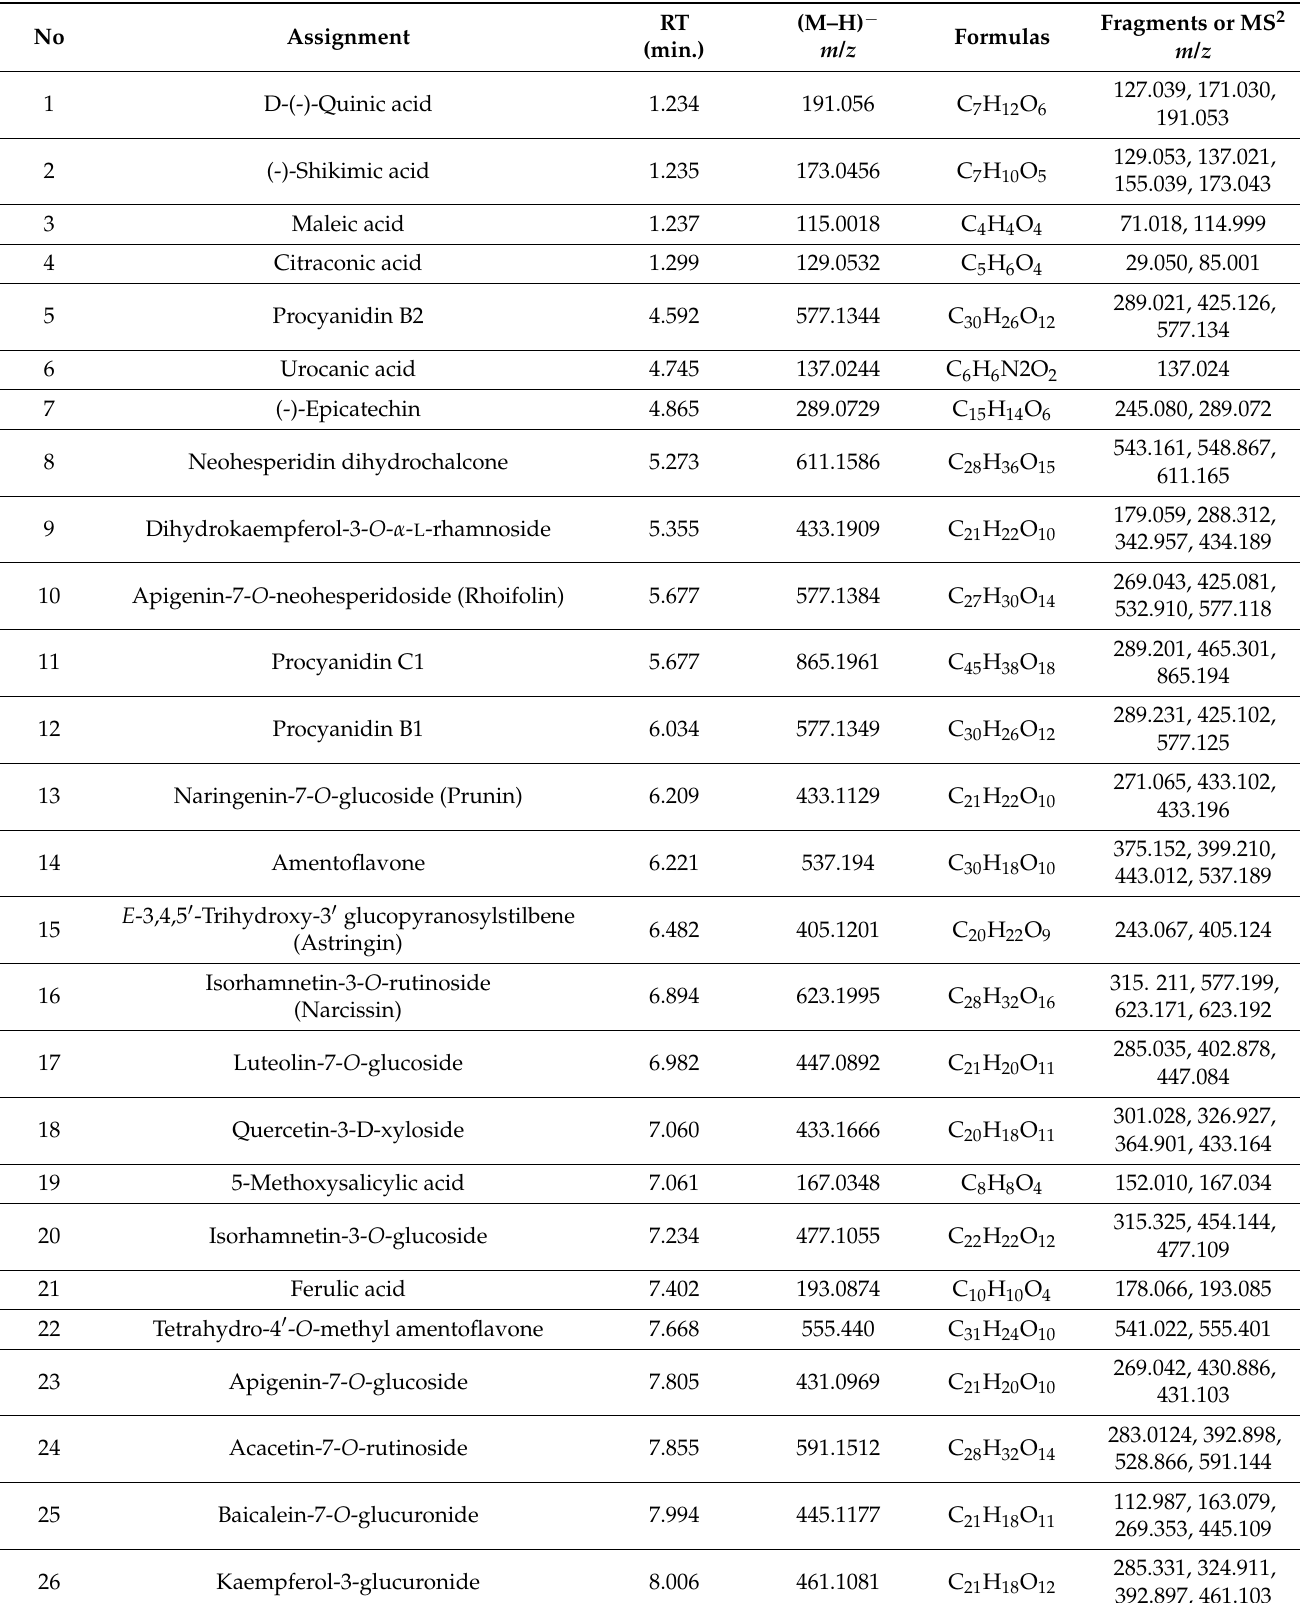
Table 1. Metabolite Profiling of CRME identified by LC-MS/MS in negative